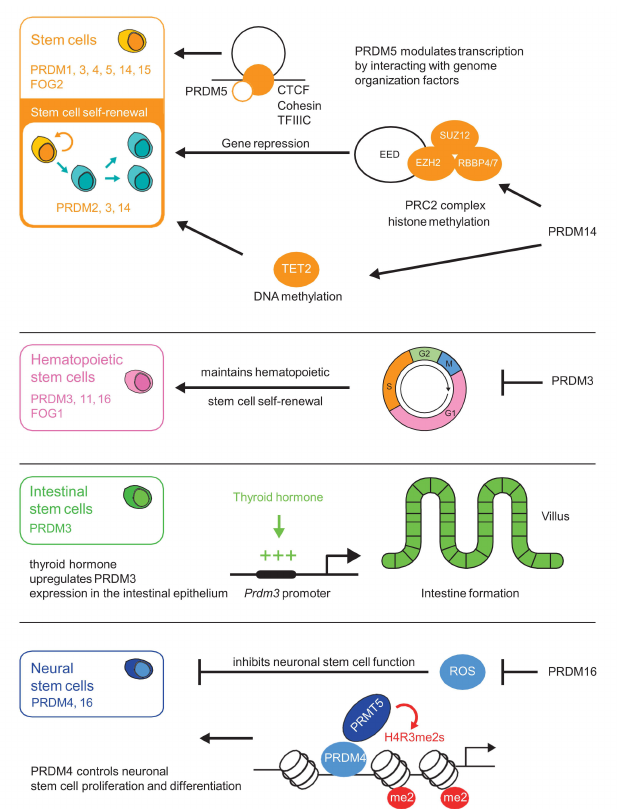
Figure 1. PRDI-BF1(positiveregulatorydomainI-bindingfactor1)andRIZ1(retinoblastomaprotein-interacting zinc finger gene 1) (PR) homologous domain containing (PRDM) factors play important roles in stem cell maintenance. PRDM3 and PRDM16 exhibit a crucial regulatory role in hematopoietic stem cell (HSC)